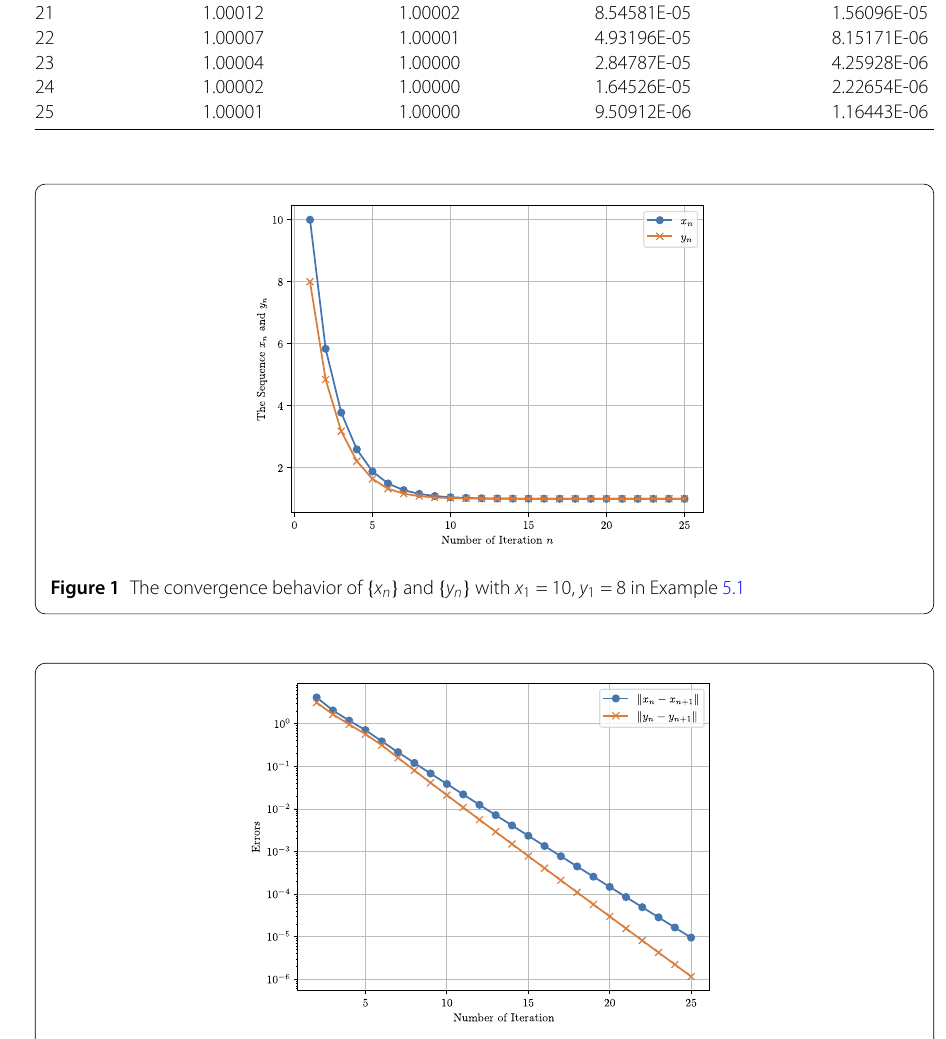
Figure 2 Error plotting of (cid:4) x n +1 – x n (cid:4) and (cid:4) y n +1 – y n (cid:4) in Example 5.1, the y -axis is illustrated on a